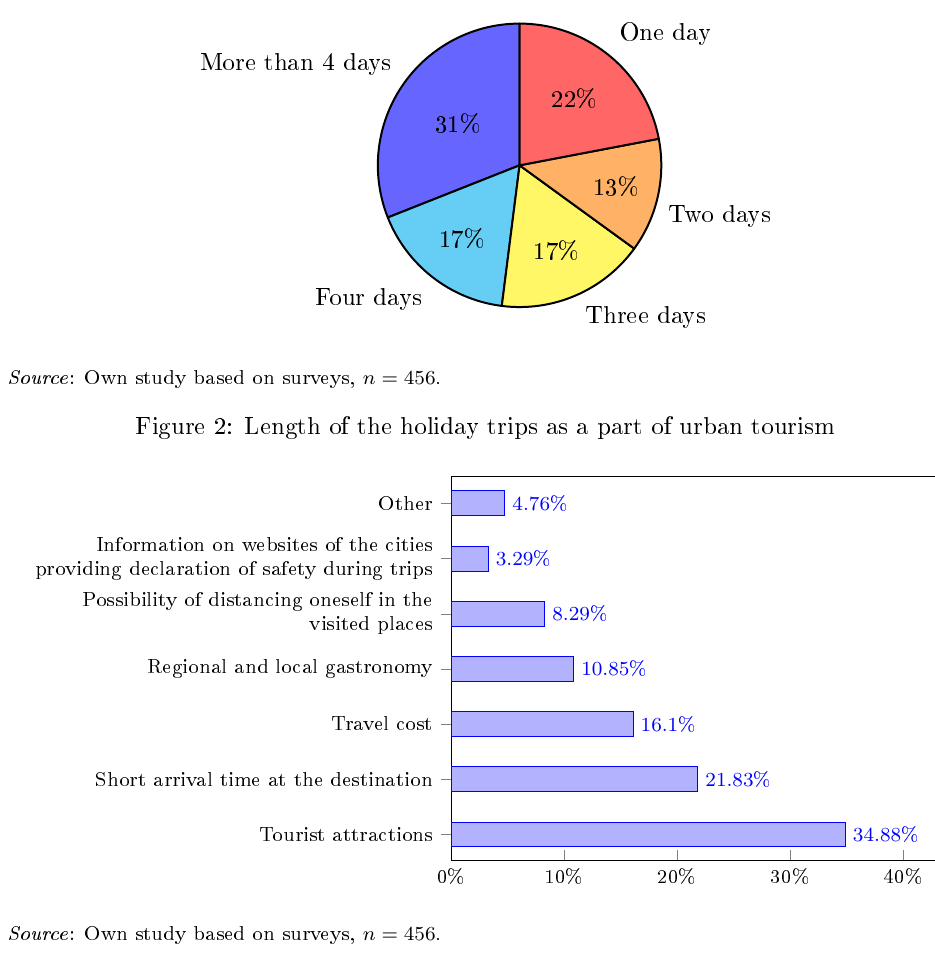
Figure 3: Factors in(cid:29)uencing the choice of the city as a tourist